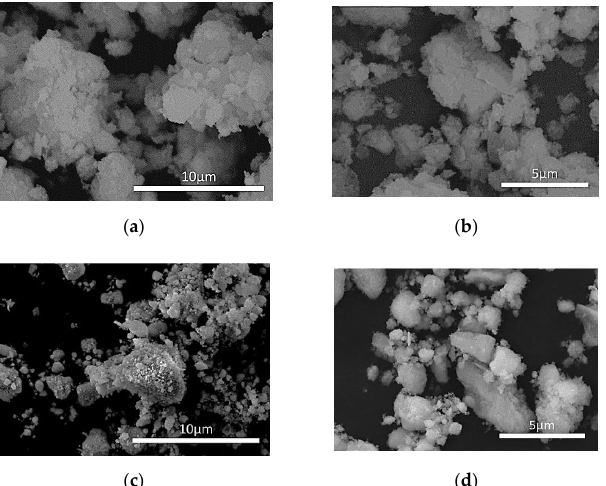
Figure 9. Scanning electron microscope (SEM) images of catalyst PROM2 ( a ) ×5000; ( b ) ×7000 and catalyst PROM5 ( c ) ×1000; ( d ) ×3000.